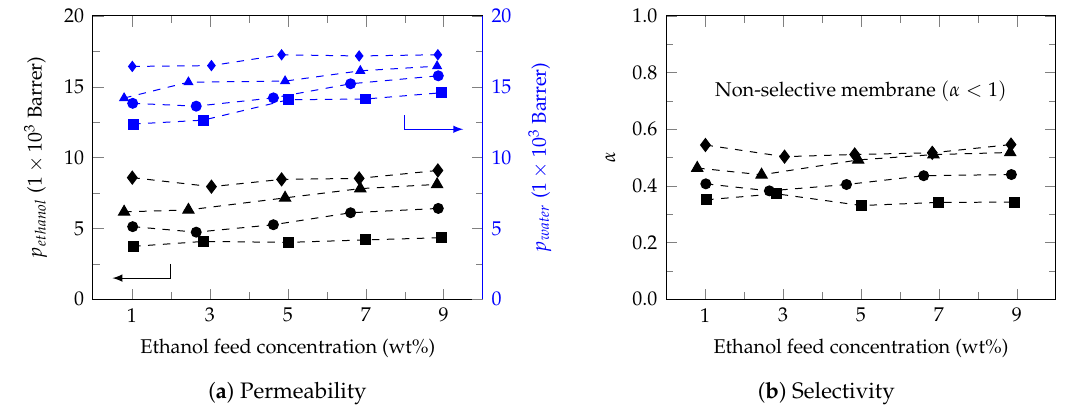
), 45°C ( (cid:78) ) and 50°C ( (cid:7) (cid:32)